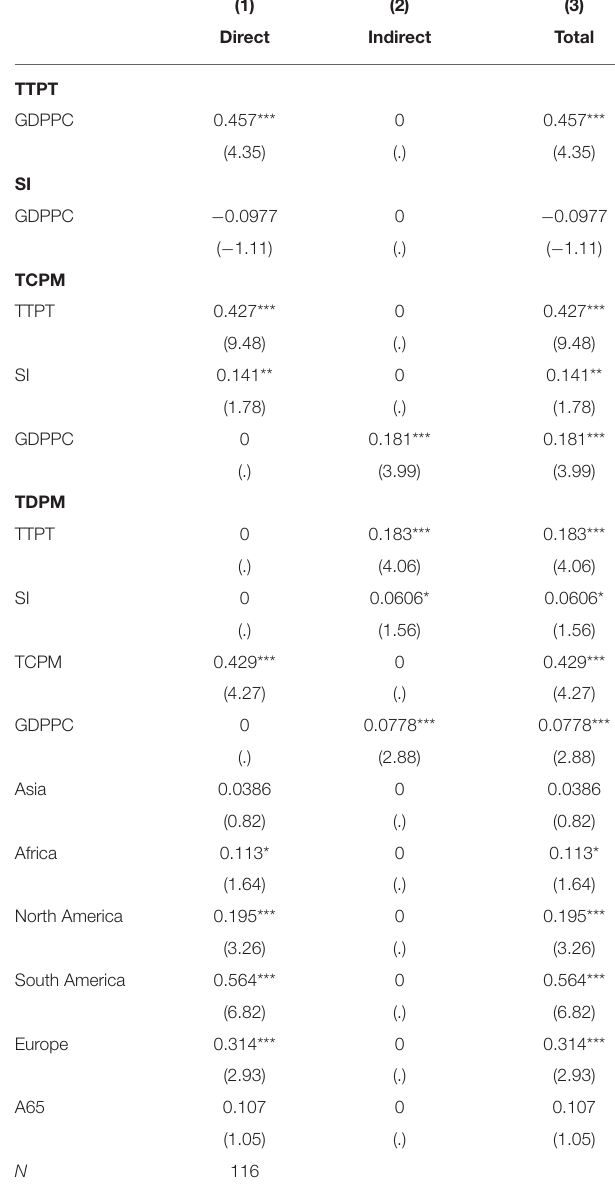
TABLE 8 | Direct, indirect, and total effects of the determinants of COVID-19 deaths via A65 with regional